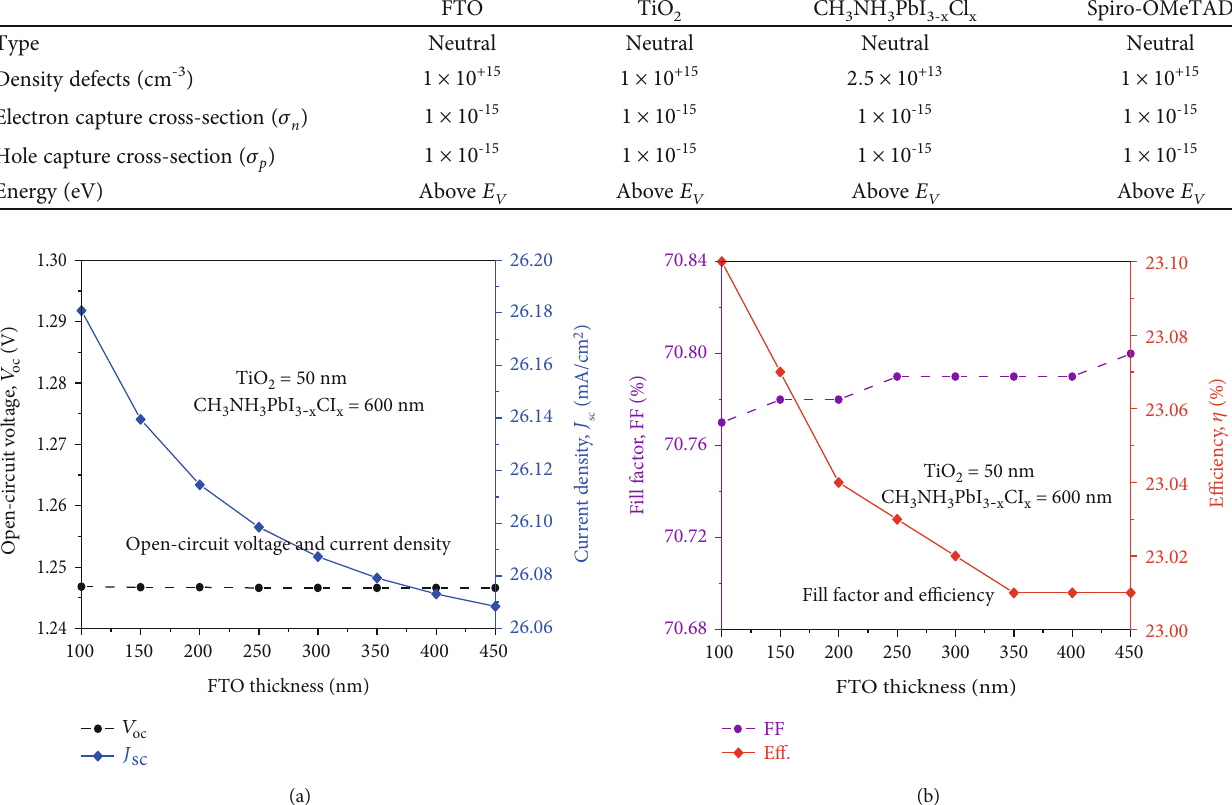
Figure 3: (a) Open-circuit and current density (b) fi ll factor and e ffi ciency as functions of FTO thickness for constant TiO Cl thicknesses. x x